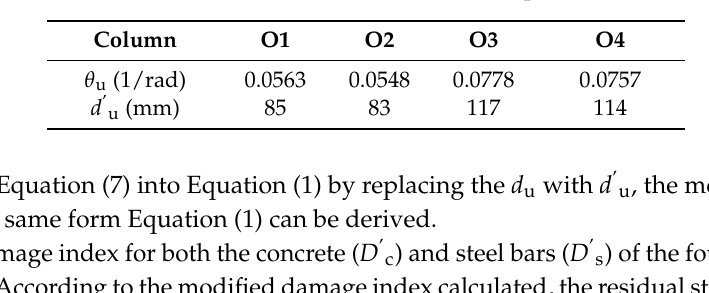
Table 5. The ultimate rotation and drift for all repaired